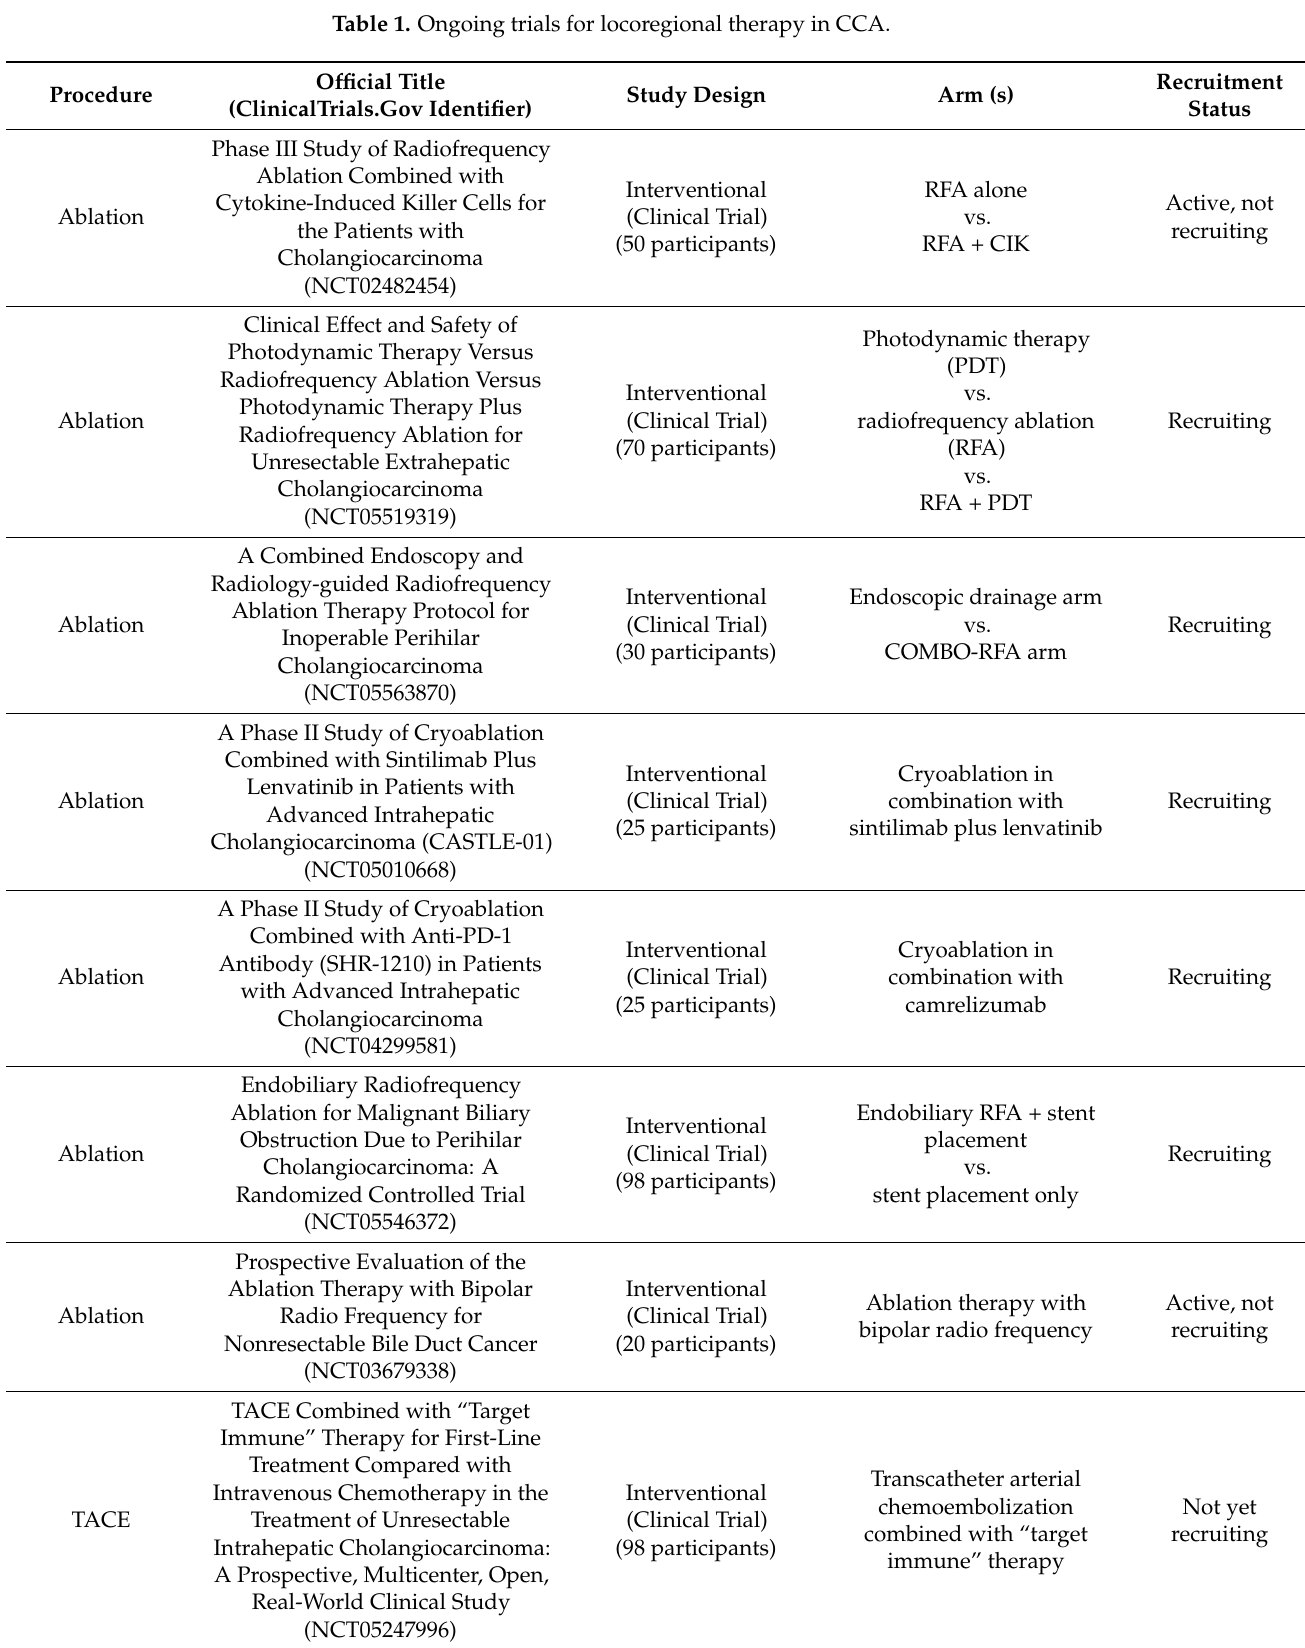
Table 1. Ongoing trials for locoregional therapy in